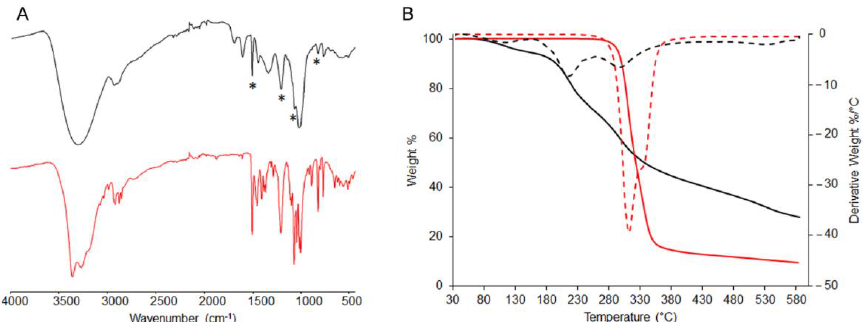
Figure 1. FT-IR/ATR spectra ( A ) and TG/DTG (solid lines/dashed lines) curves ( B ) of Arctostaphylos uva-ursi leaf extract (black lines) and arbutin (red lines). In panel ( A ), the asterisks ( * ) refer to the main arbutin peaks evident in the extract.